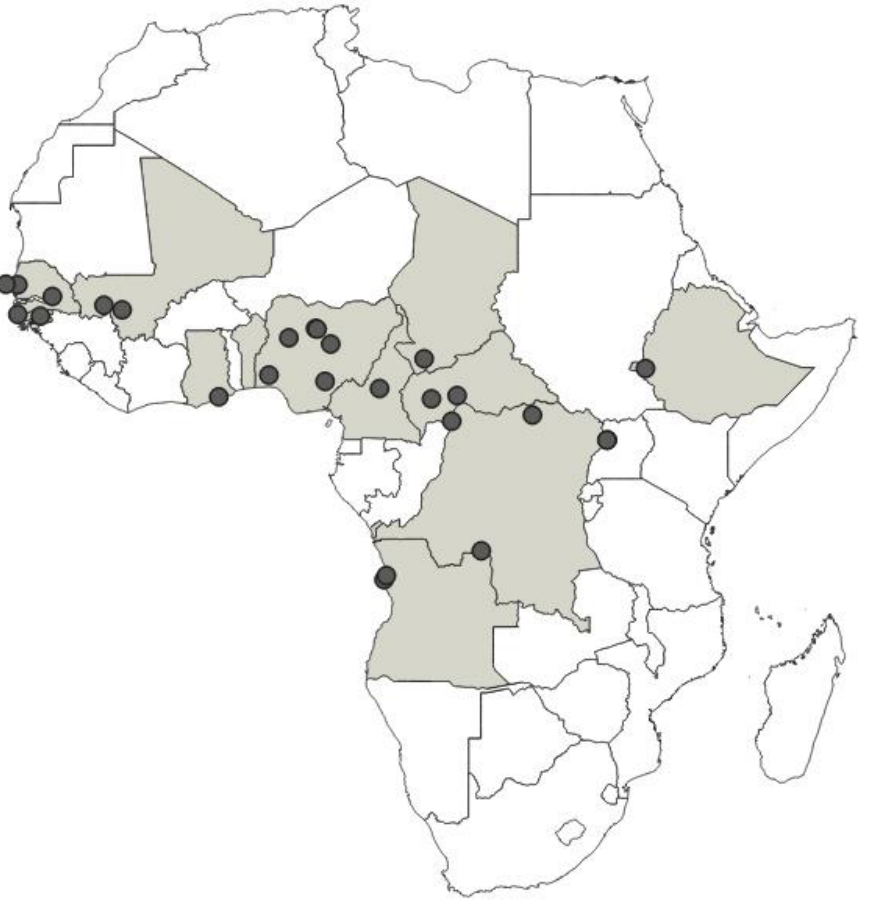
Figure 50. Known distribution of Phonoctonus lutescens (Guérin-Méneville & Percheron, 1834). 10. Phonoctonus nigrofasciatus Stål, 1855 (Figures 4D, 5D, 6J, 8J, 15B, 16L, 24C, 25C, 26M,N, 30C,D, 46B and 51) stat. rev.